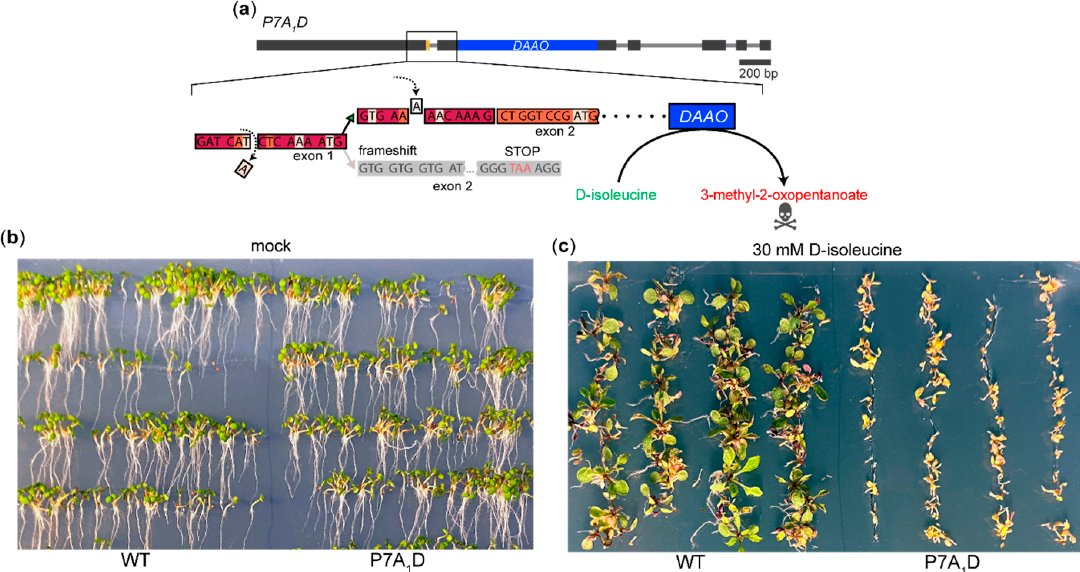
Figure 3. A screening system for the factors genetically upstream of the PIN7a / b splicing event: ( a ) A scheme of the P7A 1 D reporter. Physiologically inactive D-isoleucine is converted by DAAO to the toxic 3-methyl-2-oxopentanoate when P7A 1 D is expressed [37]. ( b ) The 6-days-old transgenic